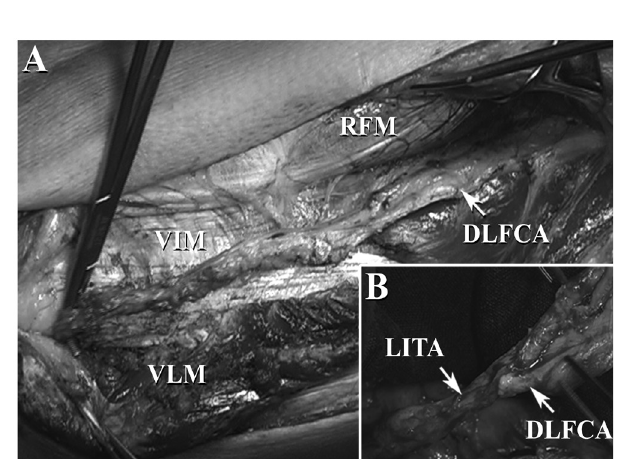
Fig. 2 – Harvesting of the DLFCA. A: Arrow points to the harvesting of the DLFCA. B: A composite graft (Y shape) constructed by the LITA and the dissected DLFCA. DLFCA = descending branch of the left femoral circumflex artery; RFM = rectus femoris muscle; VLM = vastus lateralis muscle; VIM = vastus intermedius muscle; LITA = left internal thoracic